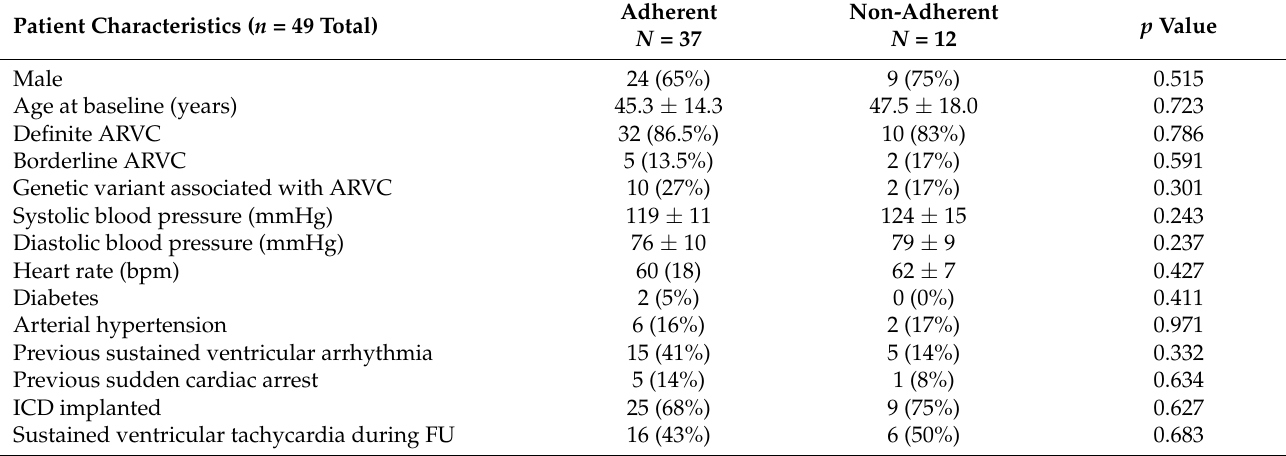
Table 1. Patients Characteristics.